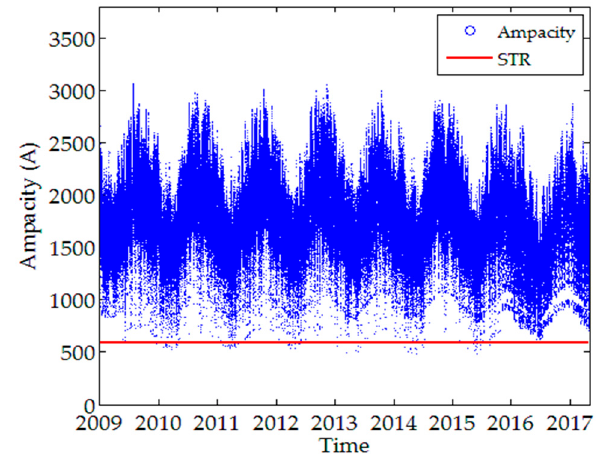
Figure 5. Ampacity with the interval of 10 minutes (Jun. 2009 to Jun. 2017).